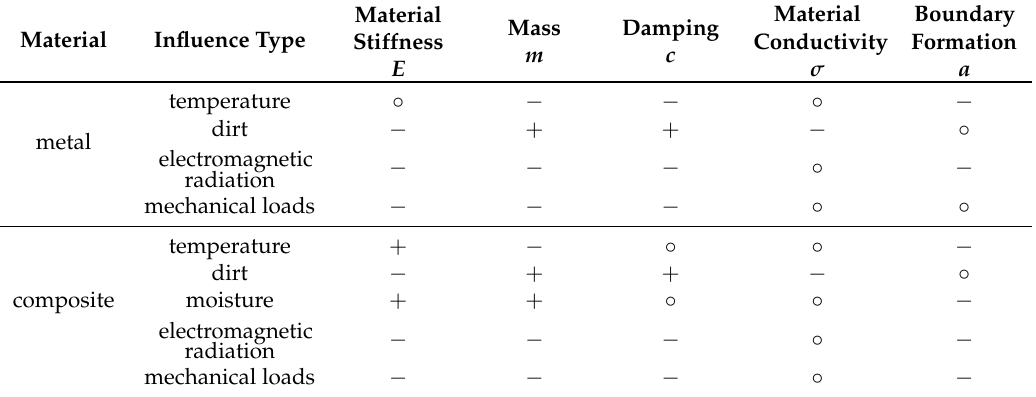
Table 2. Influence of environmental conditions on local properties of mechanical structures [29–32]: ( + ) strong, ( ◦ ) average, and ( − ) weak